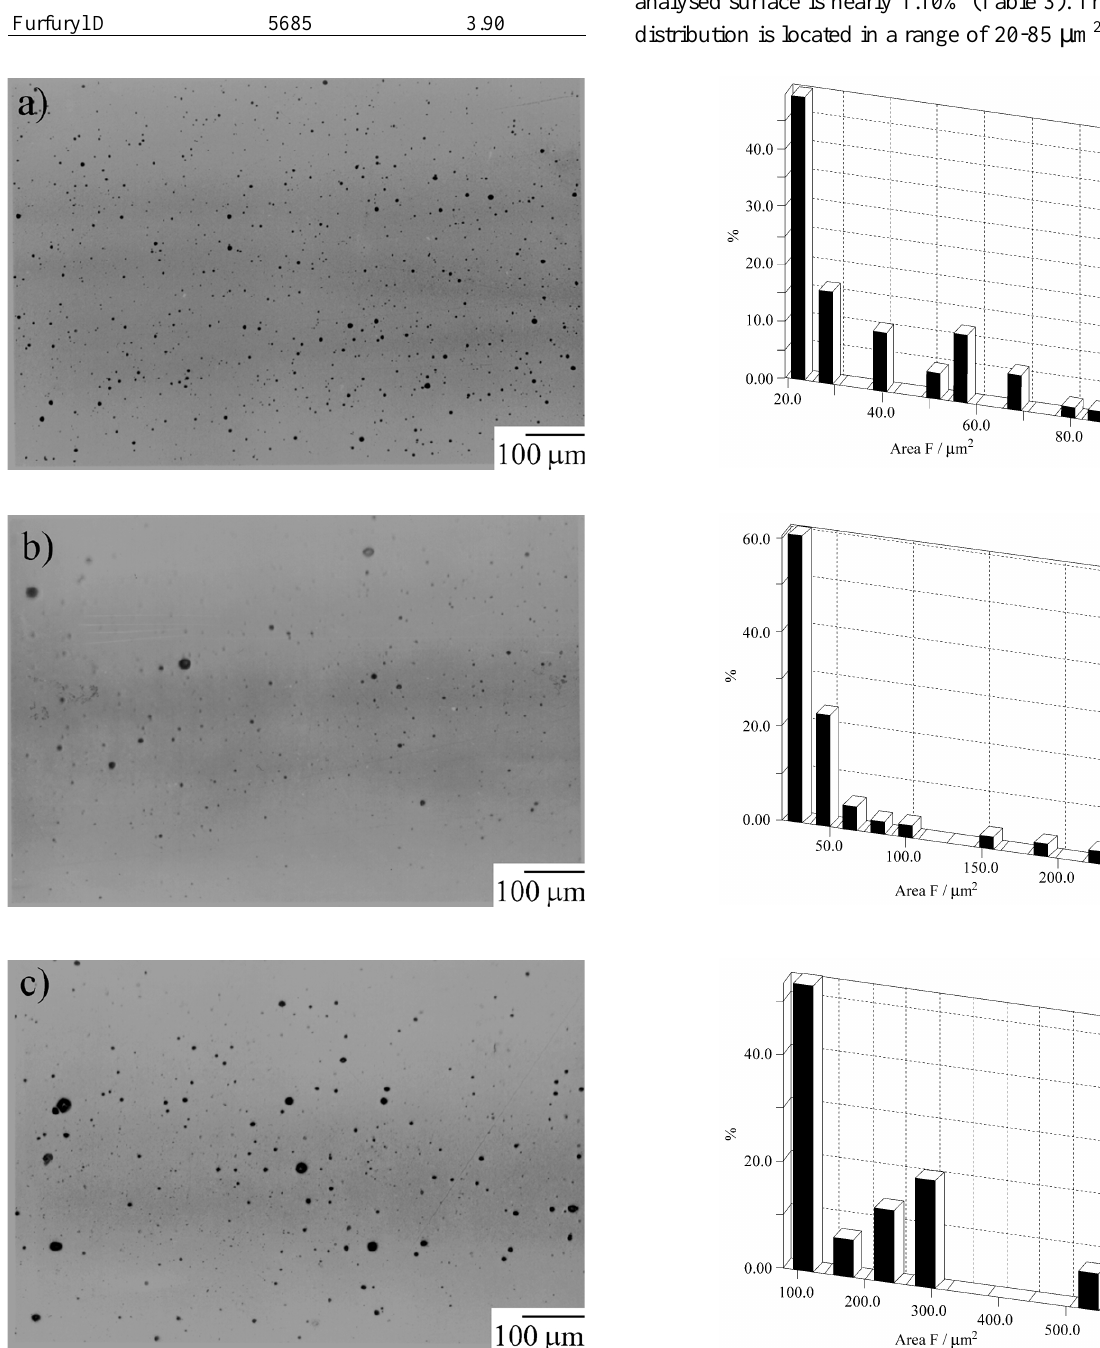
Figure 3. Optical microscopy analysis and pore size distribution histograms: a) the furfuryl resin at 50 °C; b) 60 ° and c) 70